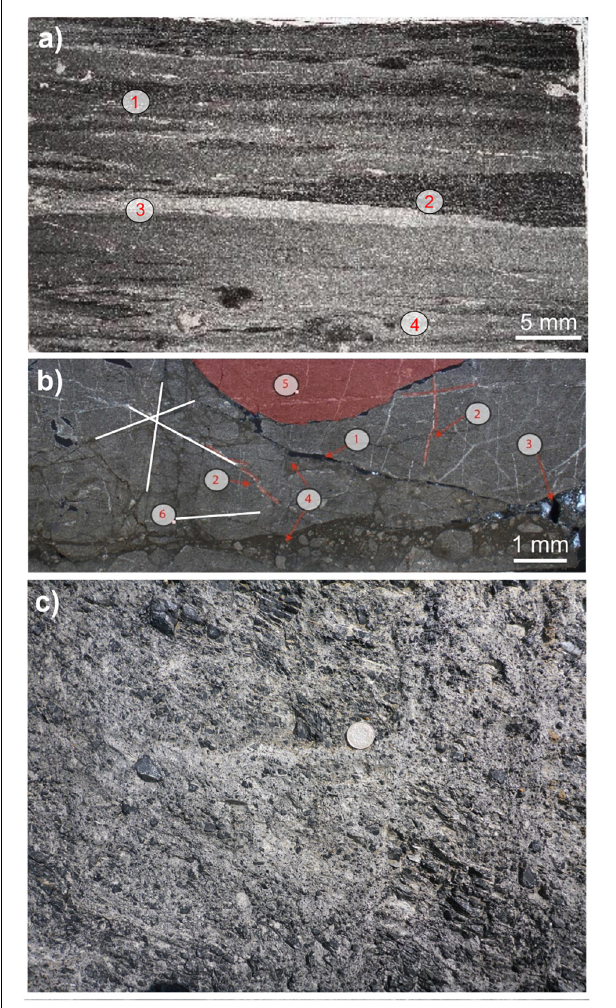
FIGURE 8 | (a) Thin section of in situ Quintnerkalk at the level of the Flims failure zone, at the southern margin of Flimserstein (cf. Figure 4 for location). 1. marl layer, 2. fecal pellets (evidence of bioturbation), compressed during diagenesis, 3. calcite-rich layer, 4. bioturbated layer with larger calcite fragments. (b) Thin section taken at the contact between in situ Quintnerkalk and the failed mass at Punt Desch (cf. Figure 2 for location). 1. voids, 2. calcite veins, 3. calcite, 4. cataclastic, comminuted limestone material, 5. limestone block, 6. (white lines) discontinuity sets. (c) Image of material at the basal sliding zone near Punt Desch, showing pulverized debris and polished fracture